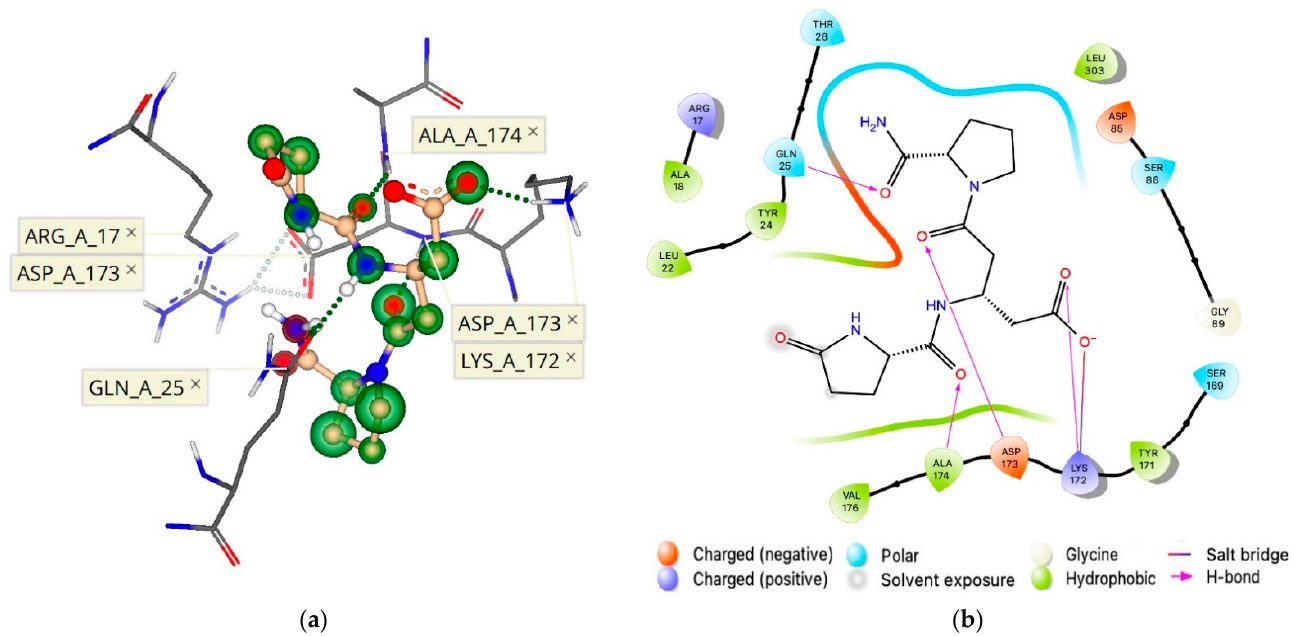
Figure 7. ( a ) A three-dimensional and ( b ) a two-dimensional pharmacophore model of 1b (Figure 1) docked to the proposed allosteric binding site of the hTRH-R homology model with an estimated binding affinity in the nM range (Table 1). Table 1. Binding affinities of TRH (Figure 1a) and TRH-like peptides (Figure 1b–e) within the proposed allosteric binding site of the hTRH-R homology model. K d denotes dissociation constant.